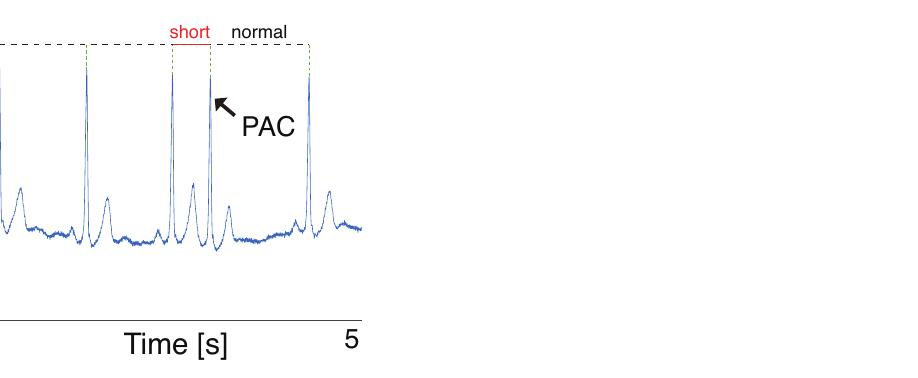
Figure 3. Example of an ECG with PAC. As the sinus rhythm resets after the PAC occurrence, only one RRI before PAC becomes short. That is, PAC does not have a compensatory pause.